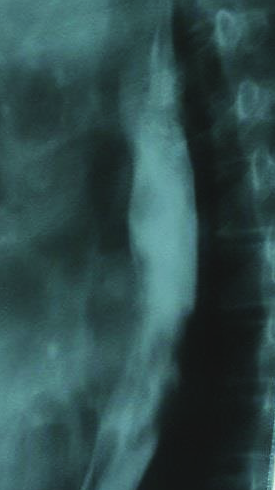
Figure 2: Esophagogram showing signs of mid-lower esophagus mass.